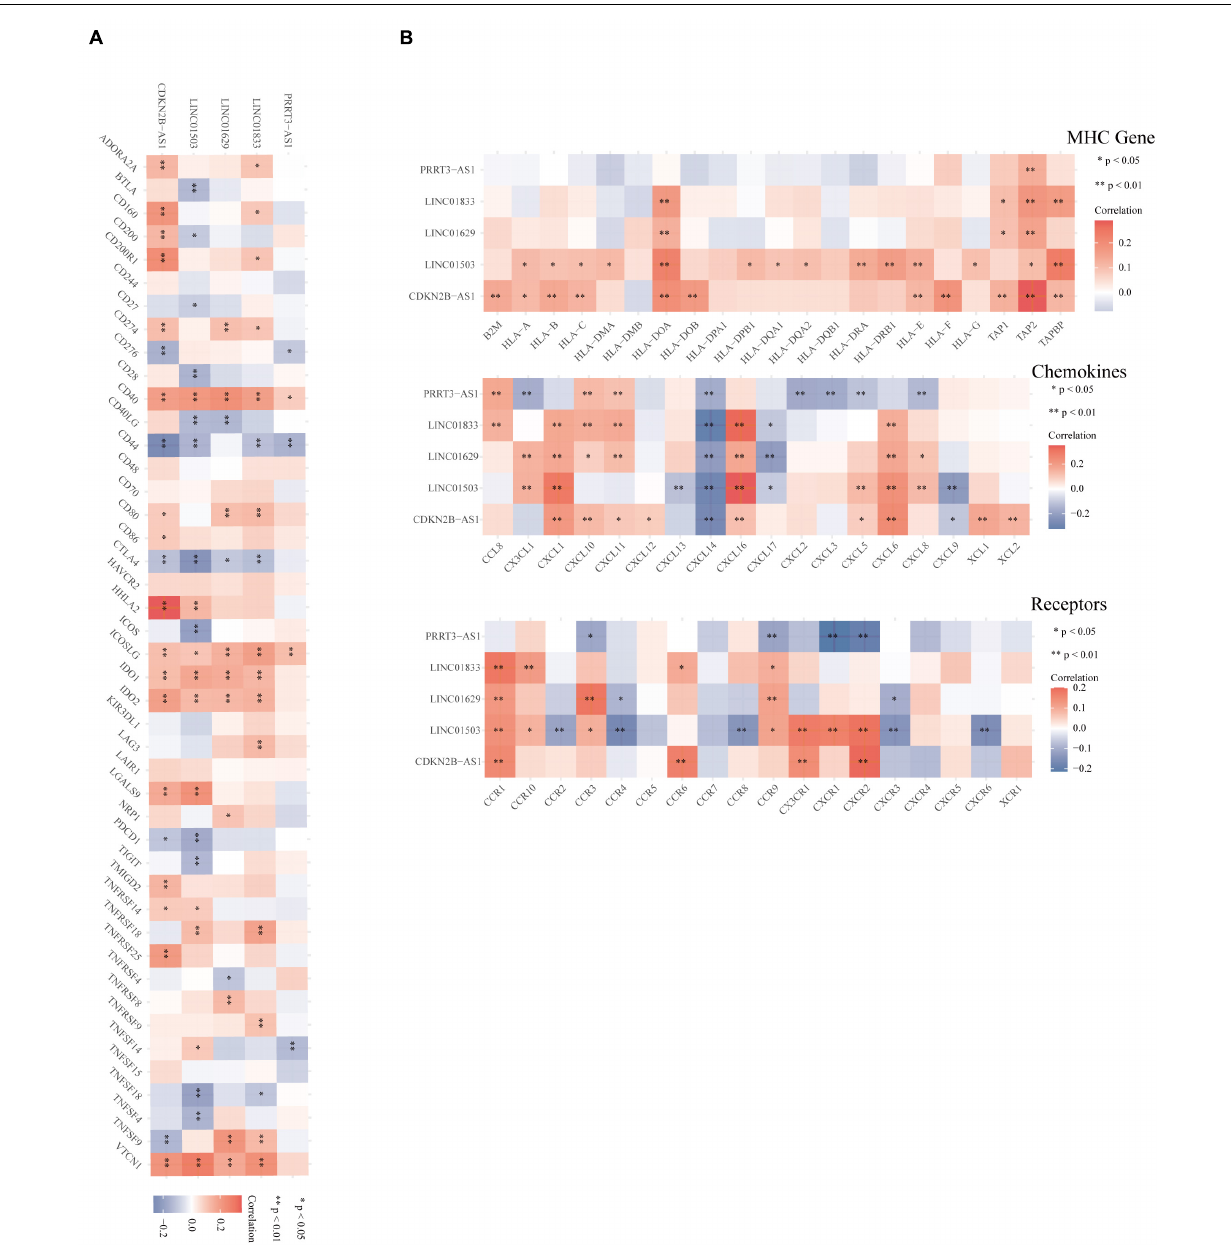
FIGURE 6 | Correlation between the immune-related lncRNA expression and immune factors. (A,B) Spearman’s correlation analysis between immune-related lncRNAs and immune checkpoints, MHC molecules, chemokines, and chemokine receptors. Different colors represent the correlation coefficient (red, positive; blue, negative). A darker color indicates a stronger correlation, ∗ p < 0.05, ∗∗ p <